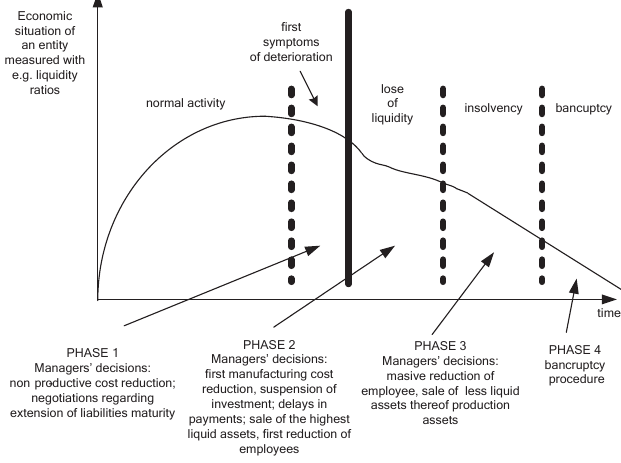
Fig. 3. Stages of company crisis (Marciniak & Głodziński,